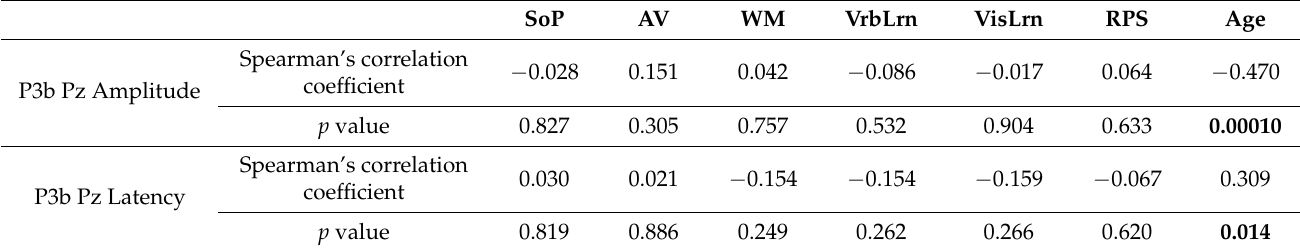
Table 4. Correlations between P3b, age and cognitive variables in